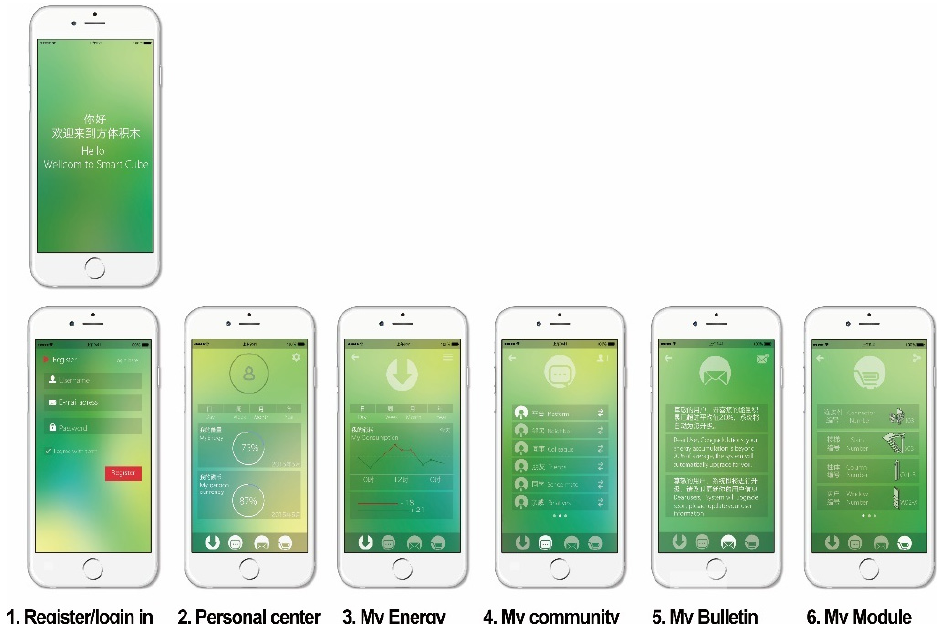
Figure 14. The operating platform of the app on the user’s mobile phone. The meanings of each stage